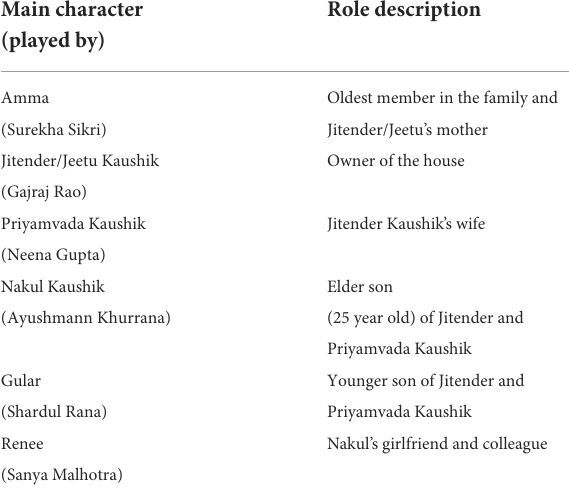
TABLE 1 Main characteristics of the film. Main character Role